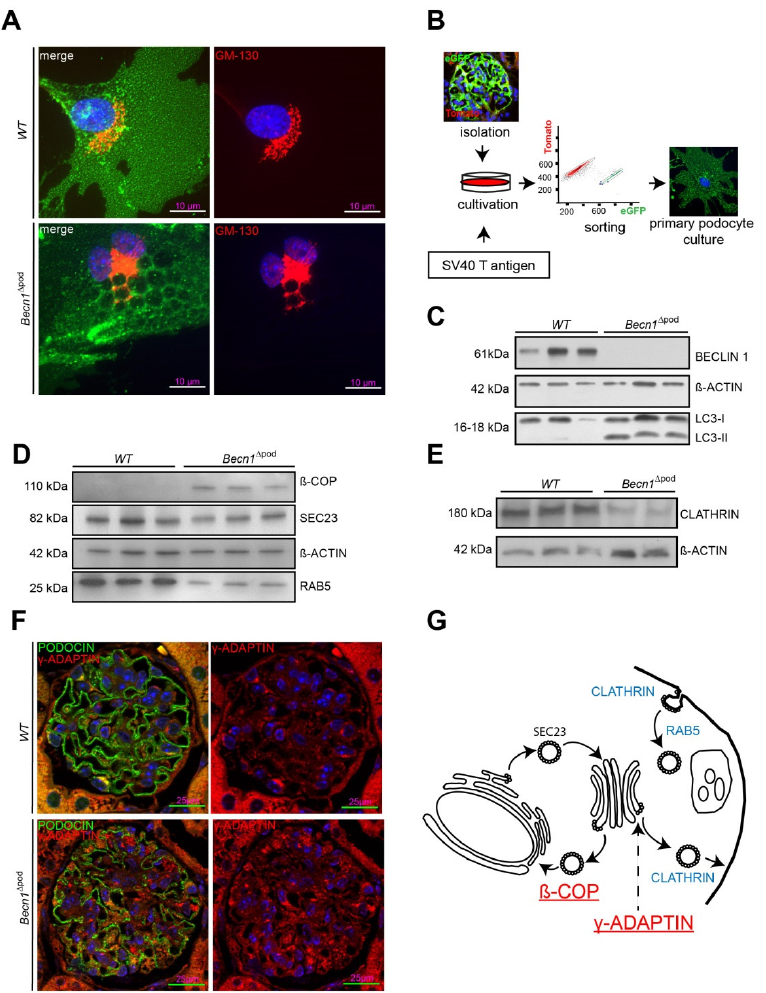
Figure 6. ( A ) Immunofluorescence staining for GM-130 (red) in primary murine WT and Becn1 ∆ pod podocytes obtained from Becn1 flox/flox x Tomato/EGFP x hNphs2-Cre and WT x Tomato/EGFP x hNphs2- Cre mice (green, EGFP fluorescence after successful Cre -mediated recombination); ( B ) Schematic showing the generation of immortalized murine WT and Becn1 ∆ pod podocytes based on glomerular isolation of Becn1 flox/flox ; Tomato/EGFP ; hNphs2 - Cre + and WT; Tomato/EGFP ; hNphs2 - Cre + with subsequent Adeno-SV40 transduction followed by fluorescence activated cell sorting (FACS); ( C ) Western blot showing the abundance of BECLIN1, ACTIN and LC3 in lysates of WT and Becn1 - deficient immortalized murine podocytes; ( D ) Western blot showing the abundance of ß-COP, SEC23, ACTIN and RAB5 in lysates of WT and Becn1 -deficient immortalized murine podocytes; ( E ) Western blot showing the abundance of CLATHRIN and ACTIN in lysates of WT and Becn1 - deficient immortalized murine podocytes; ( F ) Representative image showing immunofluorescence staining for PODOCIN (green) and γ -ADAPTIN (red) in kidney sections obtained from 4-week-old WT and Becn1 ∆ pod mice; ( G ) Schematic showing the abundance of vesicle markers in Becn1 -deficient cells indicating an accumulation of ß-COP and γ -ADAPTIN (red) and a reduction in CLATHRIN and RAB5 (blue).